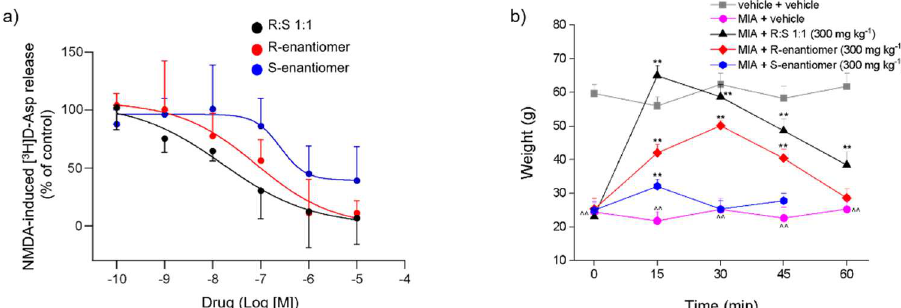
Figure 1. ( a ) Concentration-dependent (log[M]) effects of dimiracetam, R-dimiracetam, and S- dimiracetam on the release of [ 3 H]D-Asp induced by NMDA in rat spinal cord synaptosomes in superfusion. Synaptosomes were labeled with the radioactive tracer, layered on microporous filters, and superfused as described in the Materials and Methods section. Results are expressed as percent of control. Results are expressed as percent of control conditions (NMDA-induced [ 3 H]D-Asp release reported as 100% response). Data are means ± S.E.M. of 3–9 experiments run triplicate (three superfusion units for each experimental condition). ( b ) Evaluation of the effects of R- and S- enantiomers and R:S 1:1 against sodium monoiodoacetate (MIA)-induced mechanical hyperalgesia. MIA, 2 mg/25 µL, was injected into the tibio–tarsal joint of rats on day 1. Tested compounds were per os acutely administered 164 days after MIA administration at the dose of 300 mg kg −1 . Control animals were treated with vehicles. Mechanical hyperalgesia was measured on the ipsilateral paw by the Paw pressure test. Results are expressed as mean ± S.E.M. of 20 rats analyzed in 4 different experimental sets. Statistical analysis was one-way ANOVA followed by Bonferroni’s post-hoc comparison. ^^ p < 0.0 vs. vehicle + vehicle-treated animals; ** p < 0.01 vs. MIA + vehicle-treated animals.